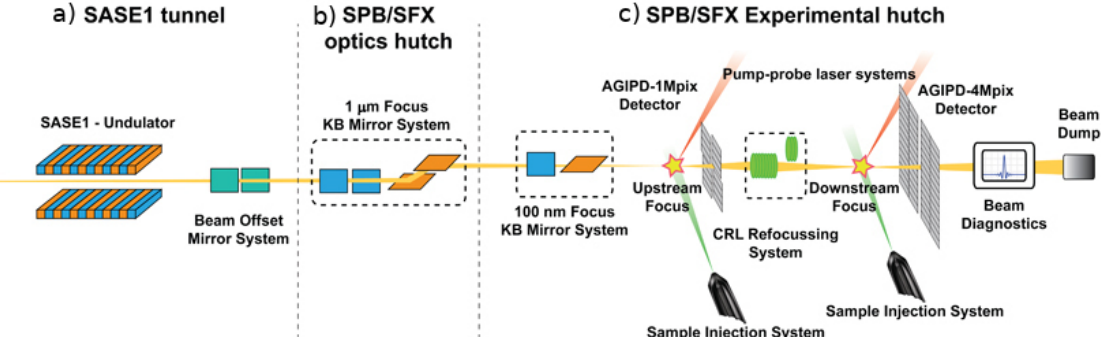
Figure 2. The Single Particles, Clusters, and Biomolecules and Serial Femtosecond Crystallography (SPB/SFX) instrument is divided into three main components: ( a ) The tunnel containing the SASE1 (self-amplified spontaneous emission) undulator and offset mirrors. The offset mirrors remove very hard X-ray higher harmonic radiation and guide the wanted X-rays onto downstream focusing optics. ( b ) The X-ray beam then enters the optics hutch, which contains the 1 µm-scale KB focusing mirror system. ( c ) The experiment hutch contains the 100 nm-scale KB focusing mirror system, the upstream interaction region where samples interact with the X-ray beam, AGIPD-1M detector, compound refractive lens (CRL) refocusing system, AGIPD-4M detector, and downstream beam